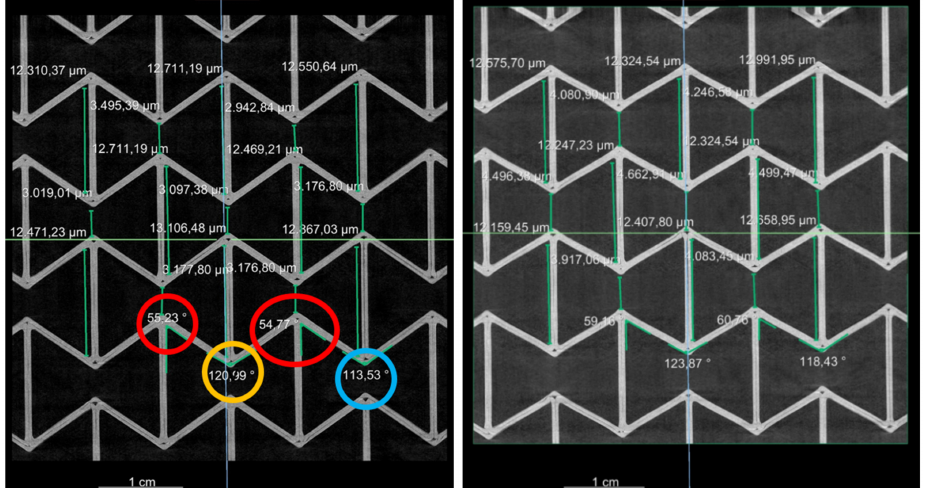
Figure 19. Measured wall length, wending points’ distance, and angles in individual honeycomb in a 5 × 5 PLA sample at 0 mm ( left ) and 4 mm ( right ) loading state in the same cut-out view as given in Figure 18. The angles marked in the red circle and ellipse are about 5 ◦ larger than the design value, while the ones marked in the yellow and blue circles are about 10 ◦ –20 ◦ larger.